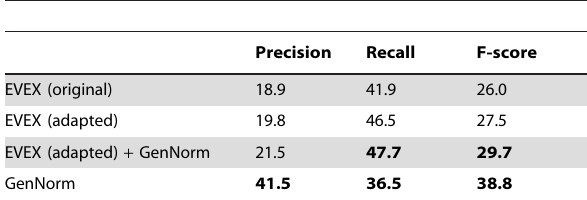
Table 5. Performance of the gene family assignment